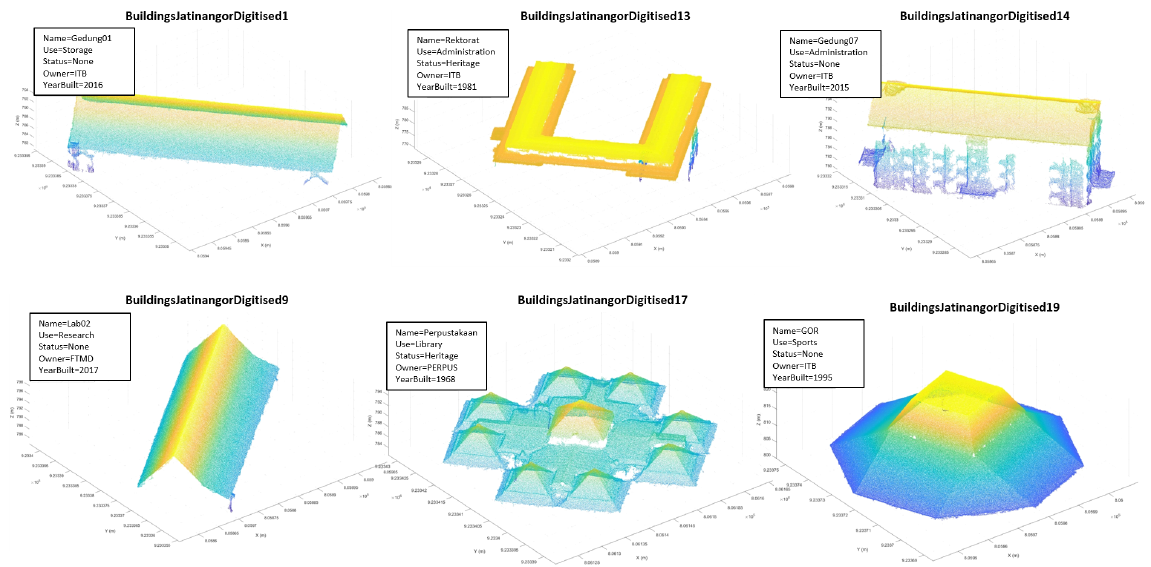
Figure 3. Result of the M_HERACLES instance segmentation, showing six of the 20 processed objects. Note the information box to the upper left of each individual figure, showing semantic attributes derived from the input 2D GIS